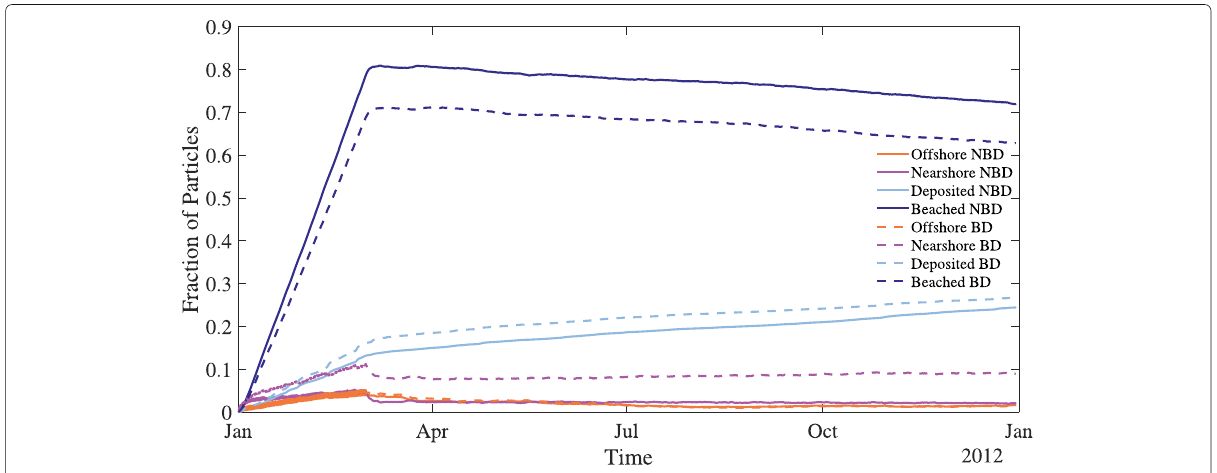
Fig. 3 Particle locations over one year for both beach type dependence (BD) and no dependence (NBD) with T b = 2 days